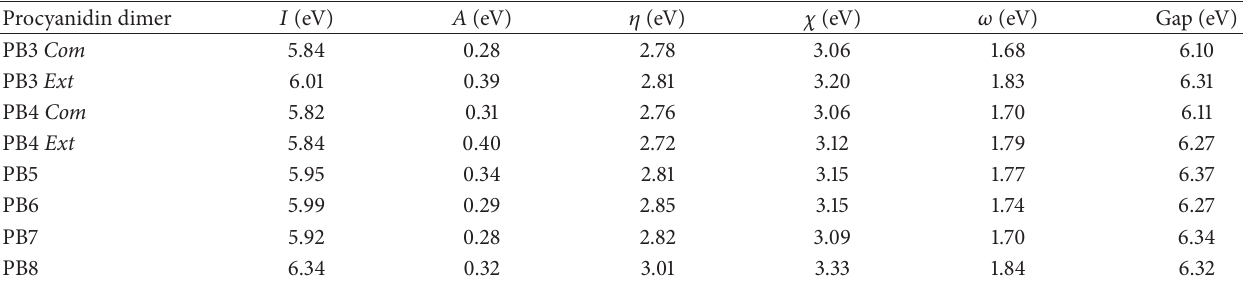
Table 2: Parameters of chemical potential and gap energy of the procyanidin dimers calculated by the M05-2X/6- 31 G ∗∗ DFT method in aqueous medium (SMD